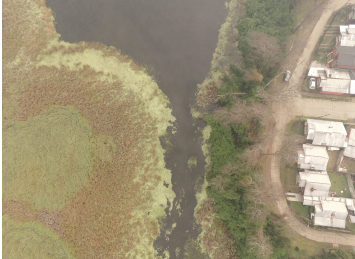
Figure 1. Aerial view of the Angachilla urban wetland showing a mosaic with three distinct compo- nents: green spaces of natural land, water body and urban